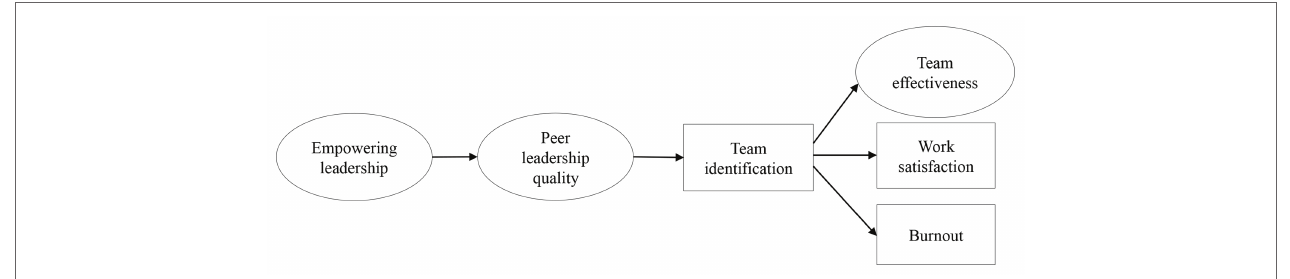
FIGURE 1 | Structural model representing the expected pathways of empowering leadership, peer leadership quality, and team identification as described in H1-4. Empowering leadership, peer leadership quality, and team effectiveness are depicted as latent variables inferred from their subscales, as discussed in the Methods